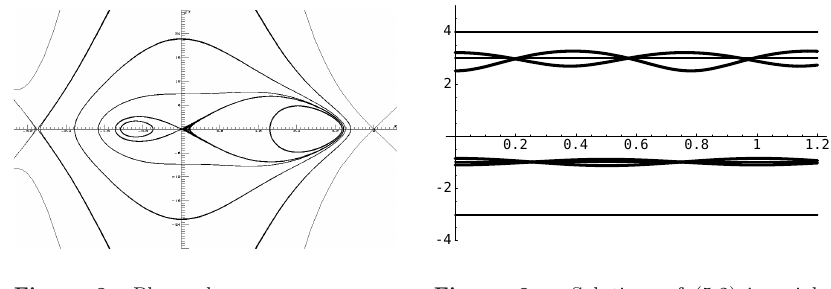
Figure 8. Phase plane. Figure 9. Solutions of (5.2) in neigh- bourhoods of the p 2 and p 4